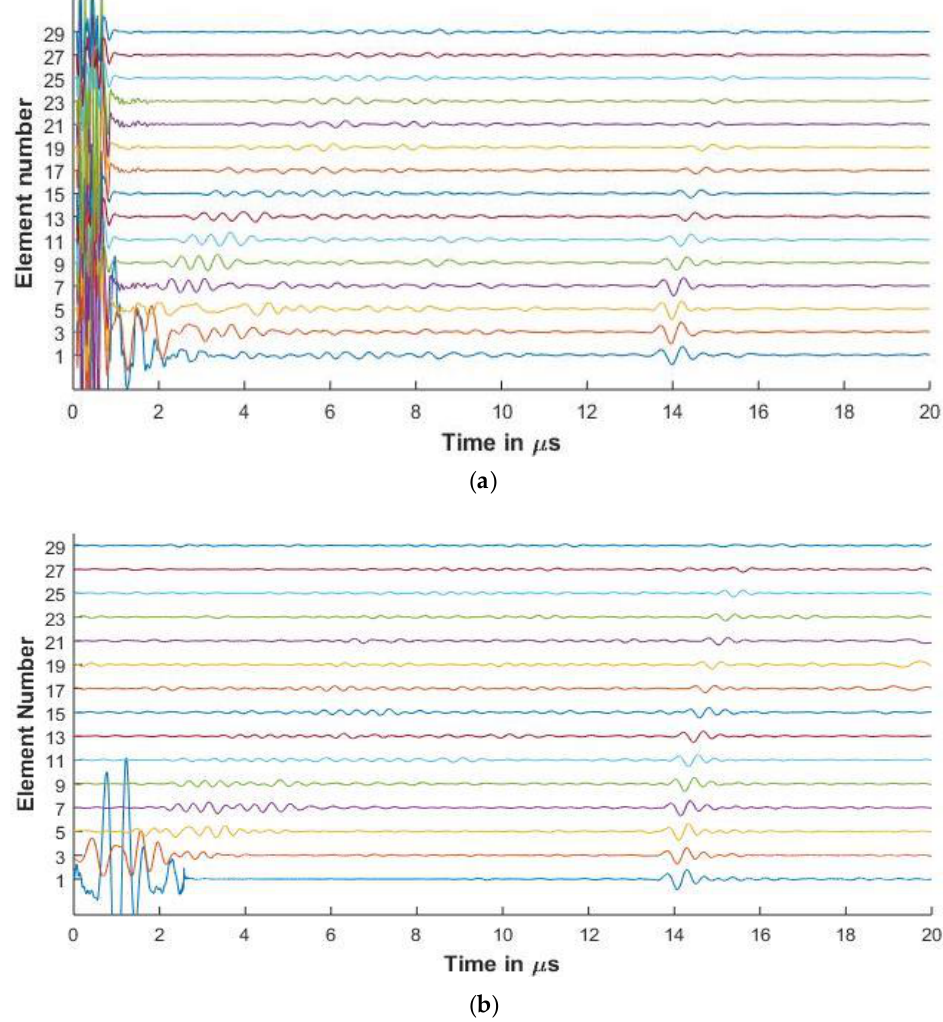
Figure8. ( a )ExperimentalFMC signalsobtainedforCFRP with2.25MHz64 elementarray( b )Simulated Figure 8. ( a ) Experimental FMC signals obtained for CFRP with 2.25 MHz 64 element array ( b ) FMC signals for CFRP with 2.25 MHz 64 element Simulated FMC signals for CFRP with 2.25 MHz 64 element array.